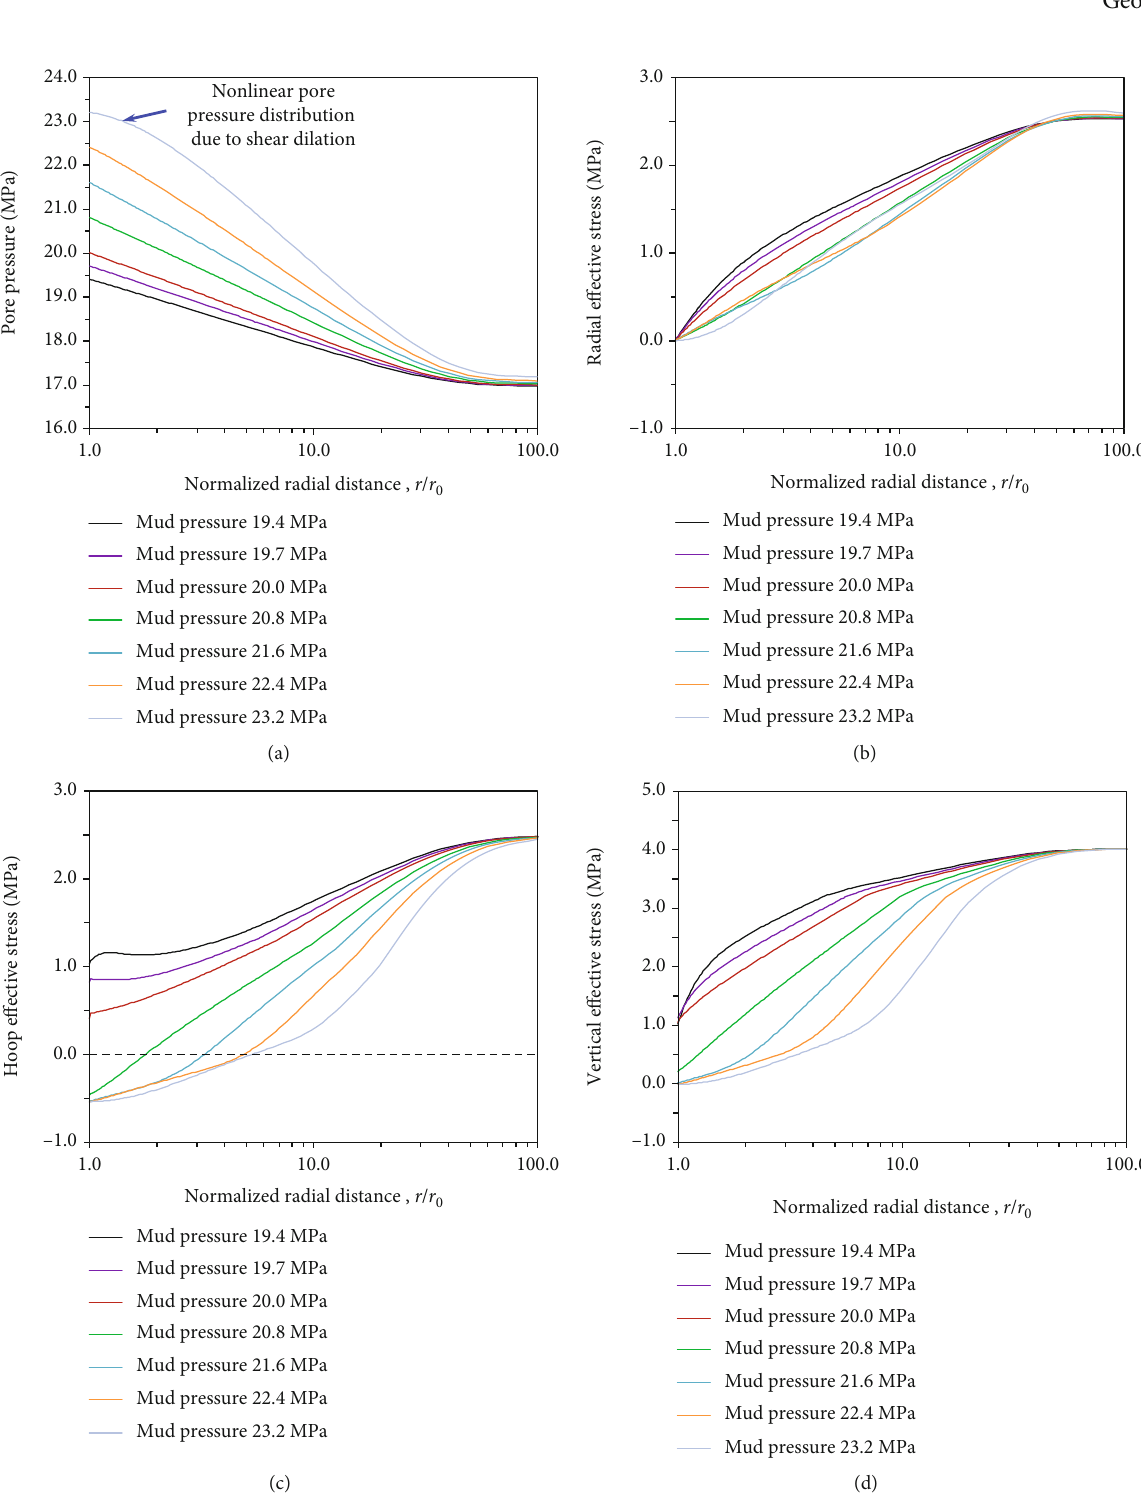
Figure 14: Distributions of pore pressure and e ff ective principal stresses along the radial direction for high mud pressures (no fl ow